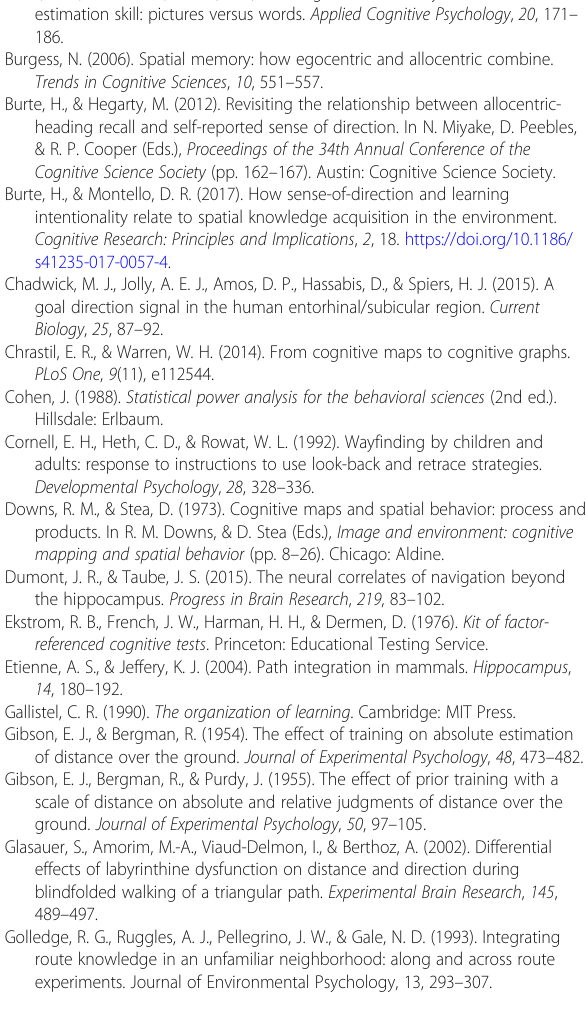
The accuracy of sketch maps for 38 participants did not show a significant improvement over the sessions. Mean bidimensional correlations for these participants ranged from .70 to .96, with a mean of .90 and a standard deviation of .06. Two participants (both male, in the feedback-only condition) showed an improvement: the de- velopmental curves for these participants had a significant linear trend, with a bidimensional correlation increasing from .40 to .94 and from .16 to